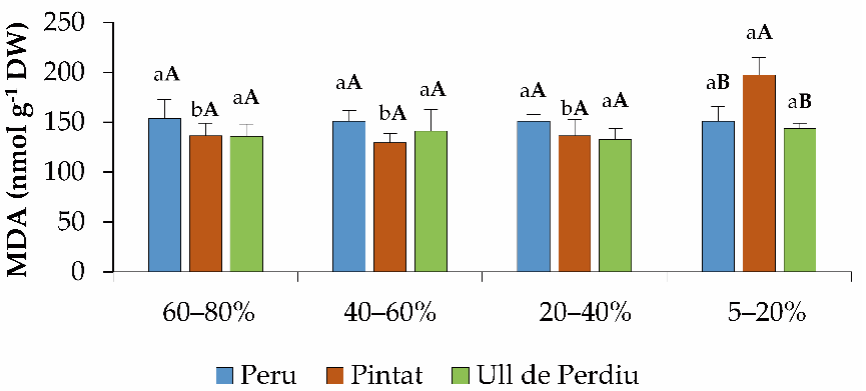
compound were observed (Figure 6).